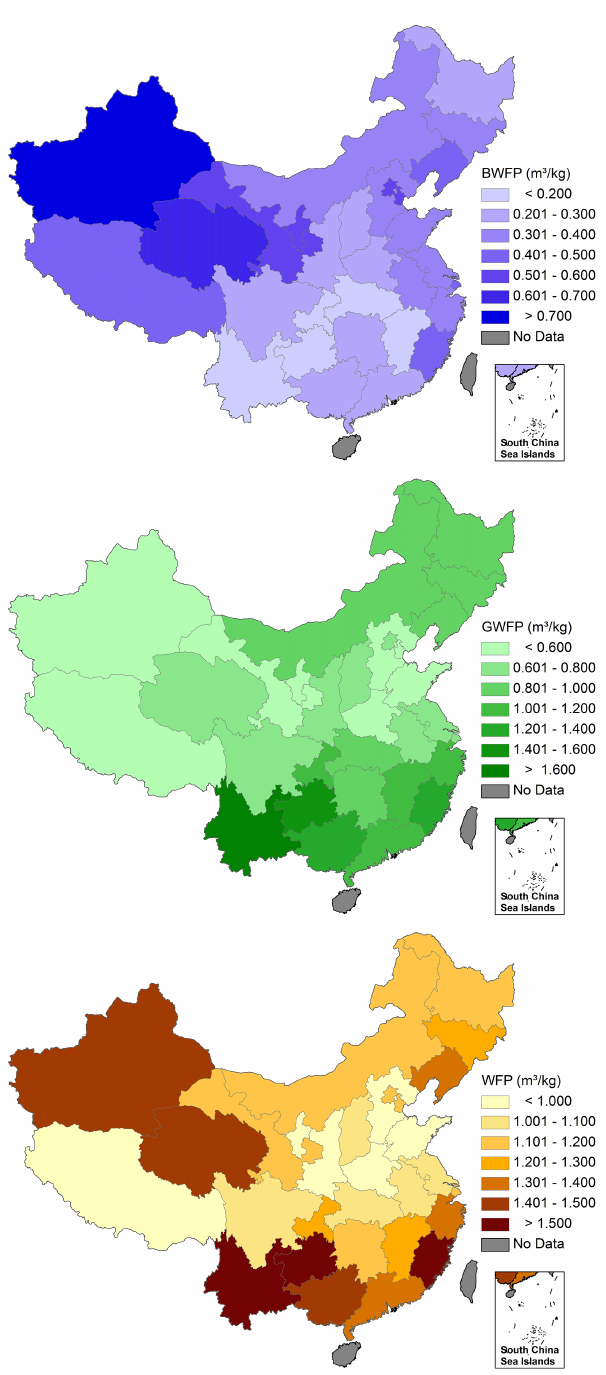
Figure 5. The blue, green and total water footprints per kilogram of wheat product in